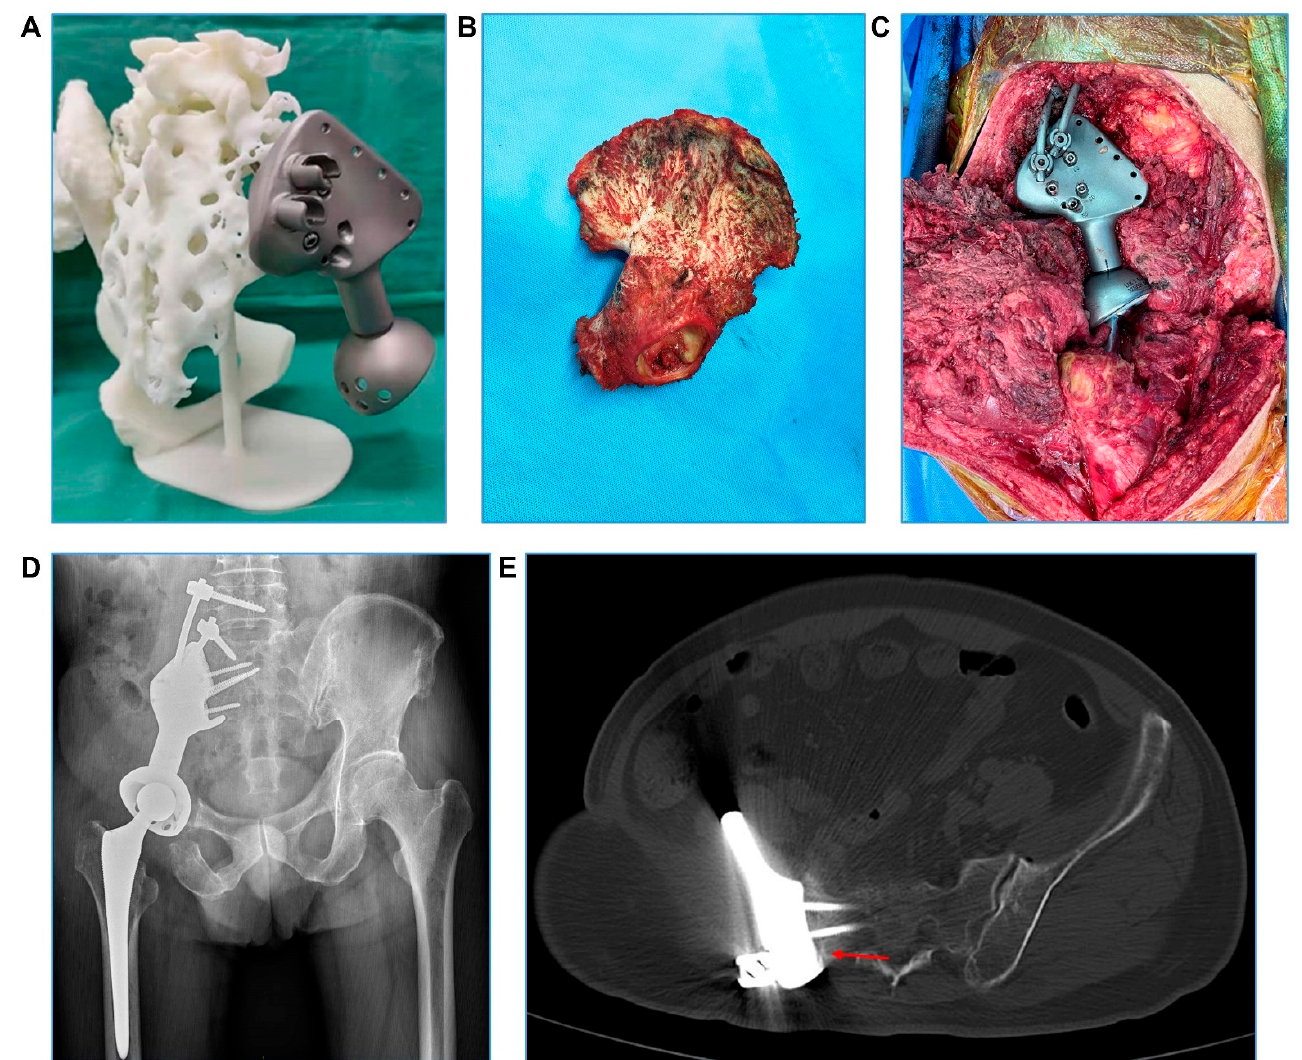
Figure 2. Case 2. Intra- and post-operative images. ( A ) Finished 3D-printed hemipelvic endopros- thesis. ( B ) The total en bloc removed ilium and acetabulum. ( C ) The 3D-printed prosthesis is installed and fixed. ( D ) X-ray shows a good implantation effect at the visit 6 months post operation. ( E ) CT shows good bone ingrowth and fusion at the prosthesis and bone interface (red arrow) at the visit 10 months post operation.